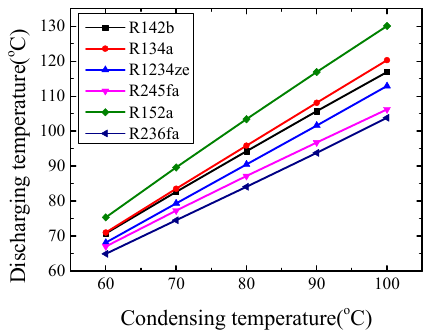
Figure 5. Comparison of discharging temperature among different refrigerants.